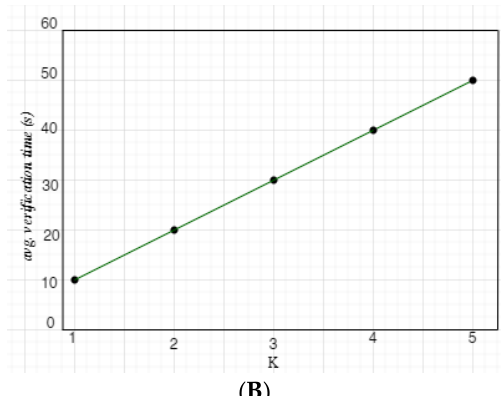
Figure 13. For example, how long it takes to verify a certain number of challenges and milestones. ( A ) Five challenges are used to calculate the distance between R and V. ( B ) Vehicle R’s range from checkpoints at each deadline. ( B ) shows that, independent of M , PM and (1 /N ) K are essentially identical, despite the fact that P1 is smaller than (1 /N ) K .